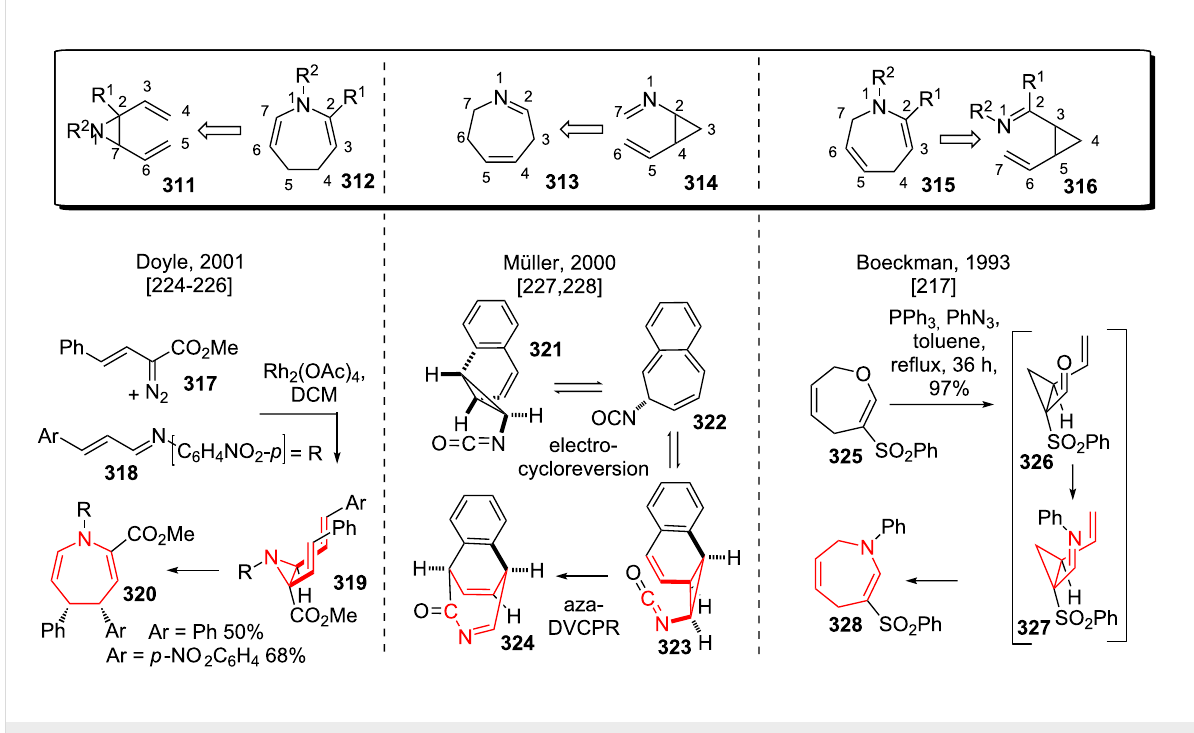
Scheme 38: Nitrogen-substituted variants of the divinylcyclopropane